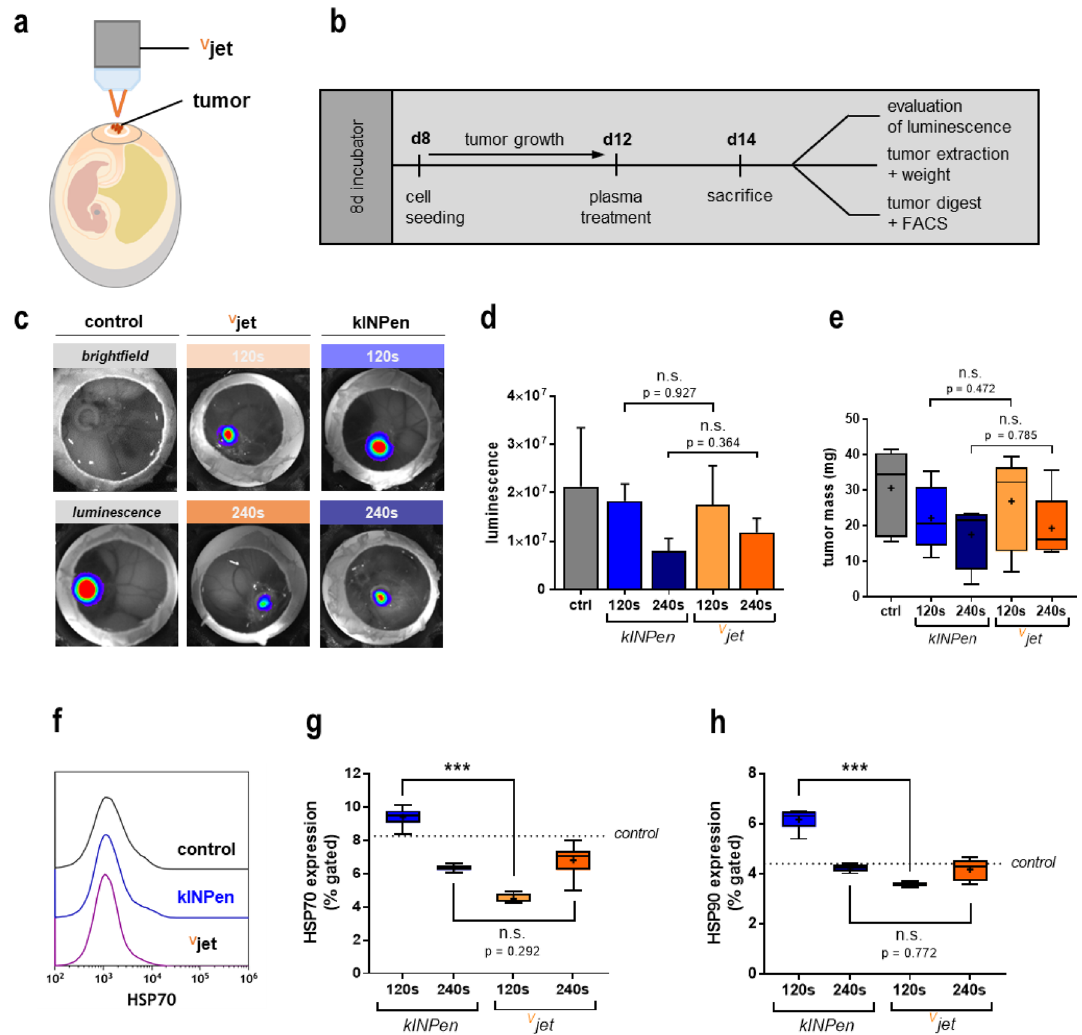
Figure 4. Tumor cell immunogenicity and reduction of tumor growth in vivo in the TUM-CAM assay following plasma treatment. ( a ) Schematic overview of plasma treatment of tumors grown on the CAM ( b ) and experimental procedure of the TUM-CAM model; ( c – d ) representative images of in vivo bioluminescent imaging of CT26 tumors 48 h after plasma treatment ( c ) and quantification thereof ( d ); ( e ) tumor mass of explanted in vivo tumors; ( f ) representative flow cytometry intensity histogram of HSP70 expression; ( g ) quantification of HSP70, and ( h ) HSP90 expression on tumor live cells digested from tumors of the TUM-CAM experiment. Boxplots show minimum to maximum with the mean indicated as (+). Data are from 5–7 eggs per group. Statistical analysis was performed using t-test (***p < 0.001). n.s. =